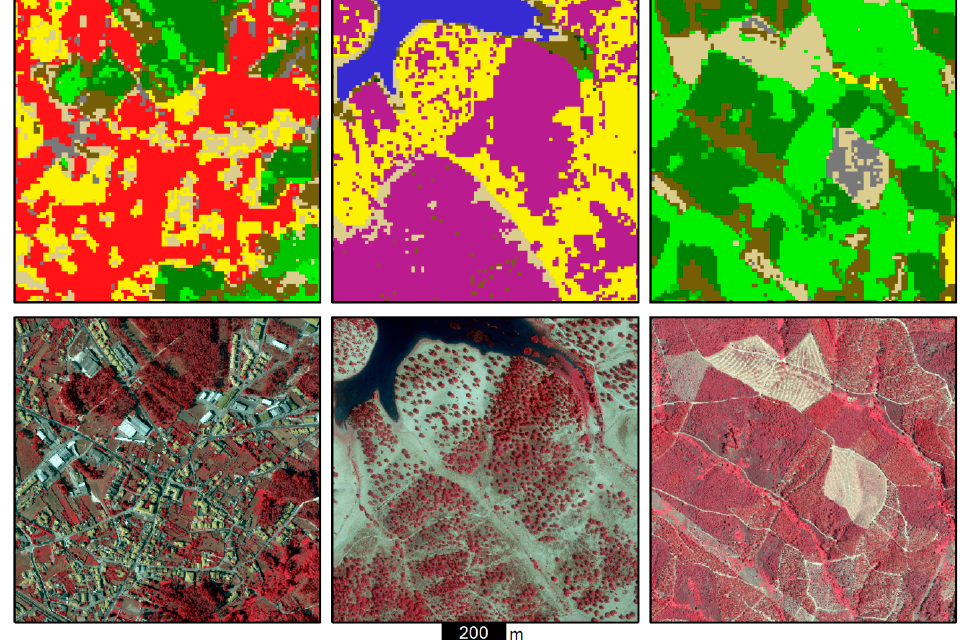
Figure 5. Examples of the land cover map over discontinuous urban fabric ( left ), agro-forestry systems of evergreen oaks ( centre ), and forest ( right ). Colour legend as in Figure 4. False colour orthophoto maps of 2018 are shown for comparison. ±2.1%. The confusion matrix is presented in Table 3. The classes mapped with higher